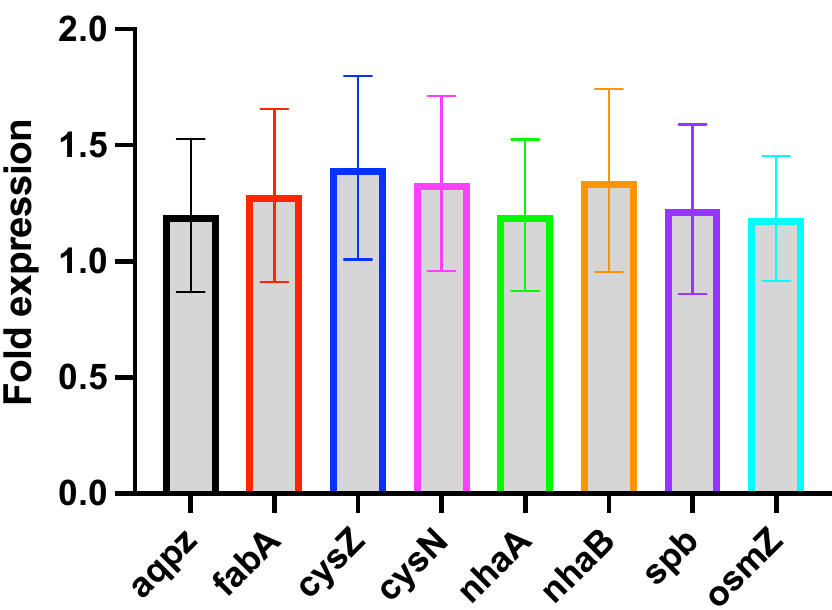
Figure 8. Comparative expression of various genes involved in water transport ( aqpZ ), sodium transport ( nhaA, nhaB ), sulfate transport ( cysZ , sbp ), sulfate metabolism ( cysN ), a global transcriptional regulator ( osmZ ), and fatty acid production ( fabA ). We do not find significant changes in the expression of these genes ( (cid:104) ∆∆ C t (cid:105) ≤ 0.5 ) at high salt concentration during the exponential growth phase. cysZ and nhaB exhibit slight upregulation within the error bar. However, this is not conclusive from our data due to large error bar with the (cid:104) ∆∆ C t (cid:105) ≤